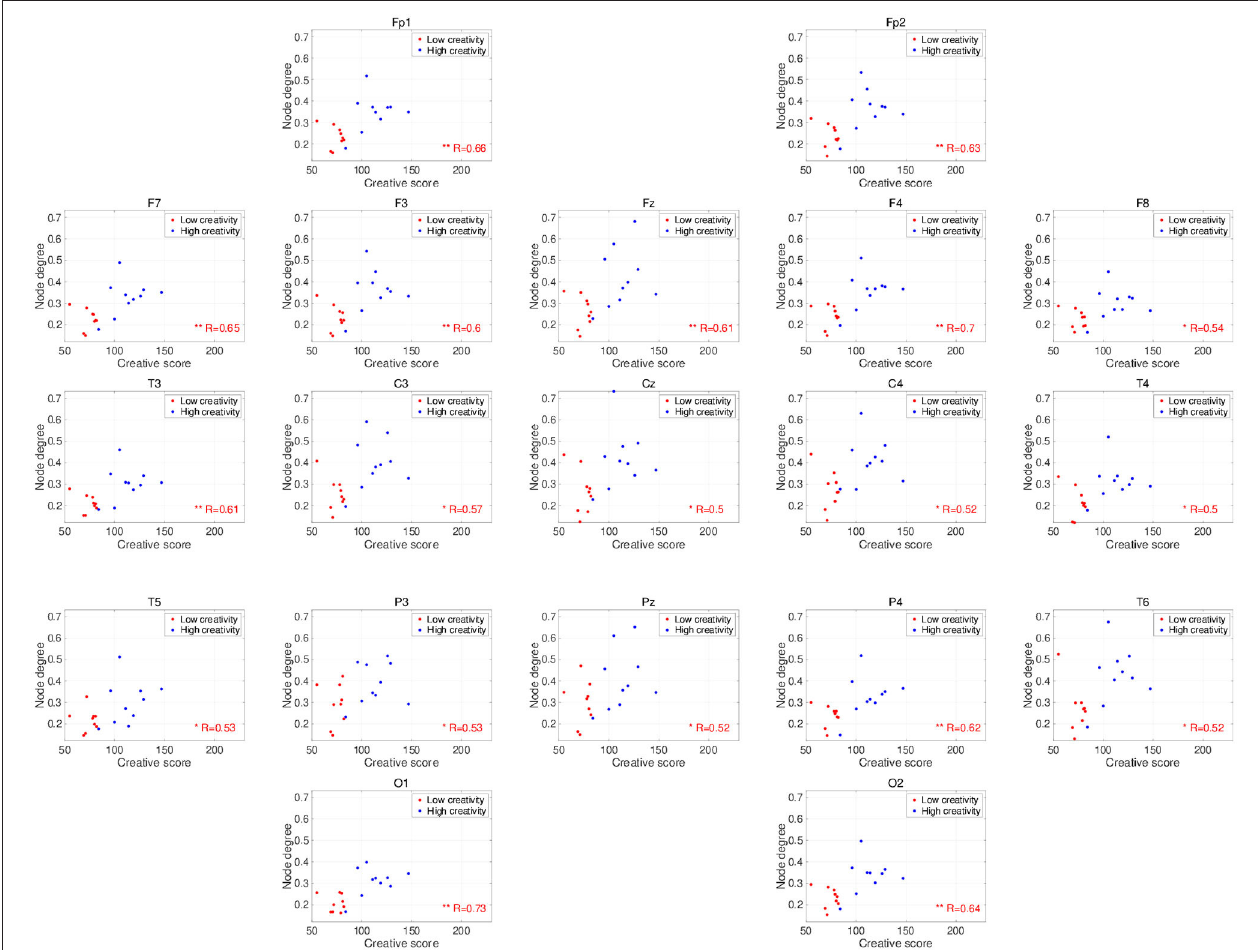
FIGURE 4 | Scatter plots showing the relationships between the node degrees calculated from the PLIs in the alpha band and creativity scores. R is the Pearson correlation coefficient. Electrodes with significant, high correlations are labeled in red ( ∗ FDR criteria q < 0.05; ∗∗ q <